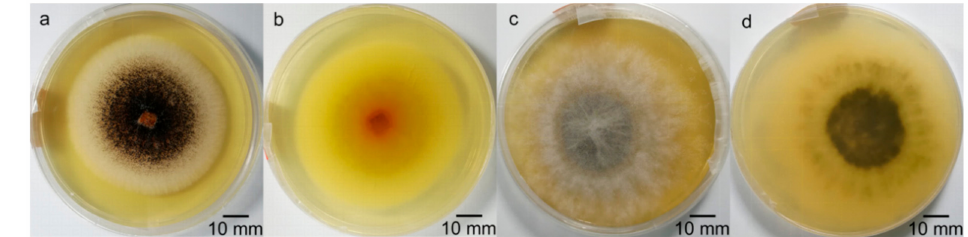
Figure 4. Morphology of pathogen A (5 days) and B (3 days) on PDA plates. Front ( a ) and back ( b ) of pathogen A on PDA plates; front ( c ) and back ( d ) of pathogen B on PDA plates.